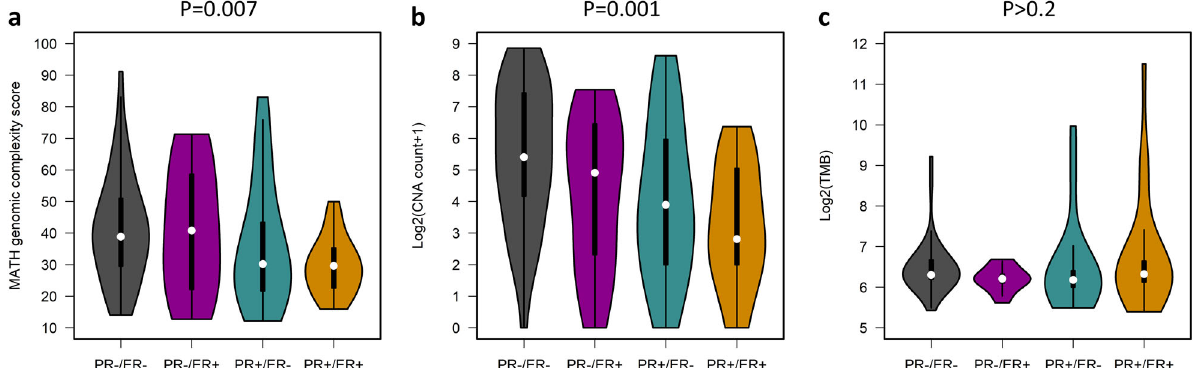
Fig. 2 Genomic characteristics of endometrioid ovarian carcinoma subtypes de fi ned by hormone receptor expression patterns. a Mutant- allele tumour heterogeneity (MATH) genomic complexity score. b Total number of copy number alterations (CNAs). c Overall tumour mutation burden (TMB). Labelled P values represent comparison of PR-high (PR + /ER + , PR + /ER − ) and PR-low (PR − /ER + , PR − /ER − ) cases with a two-sided Mann Whitney-U test. For TMB analysis, statistical power to detect a difference between PR-high and PR-low was 0.78 using a two- sided Mann Whitney-U test, assuming exponential distribution and an effect size P(X < Y) of 0.667. PR, progesterone receptor; ER, oestrogen receptor.